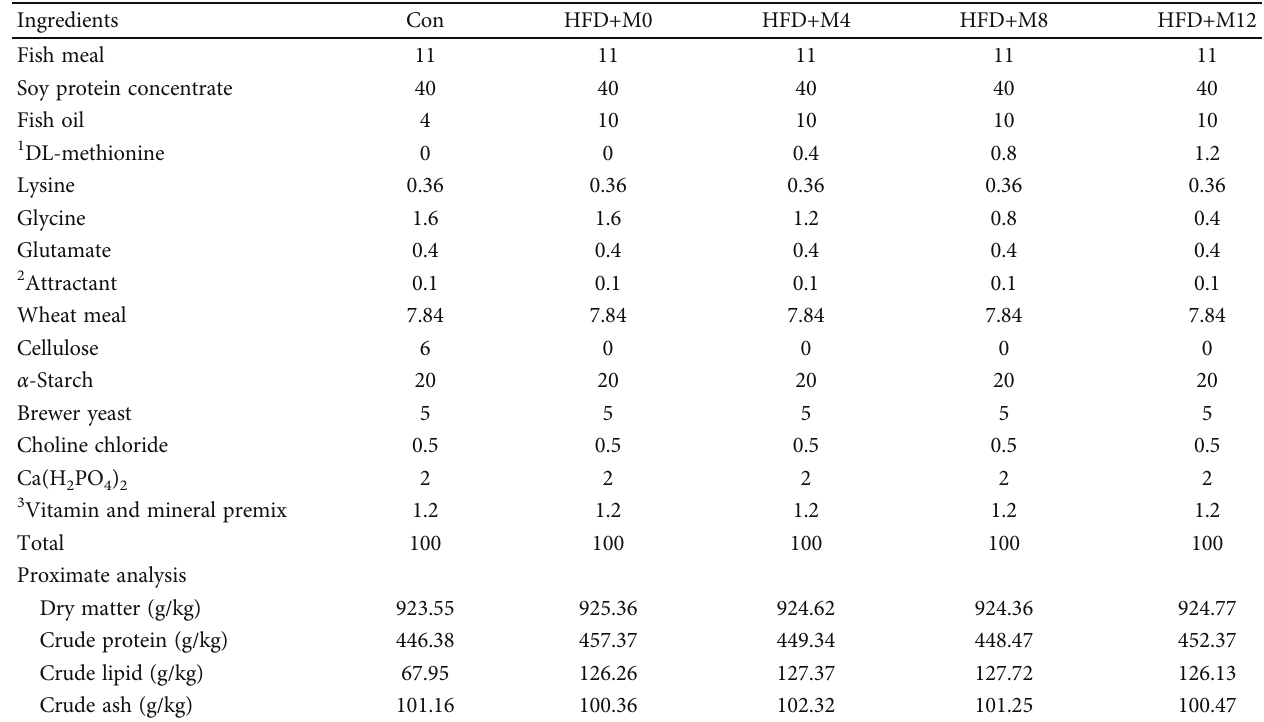
Table 1: Experimental diets and level of nutrition (%).